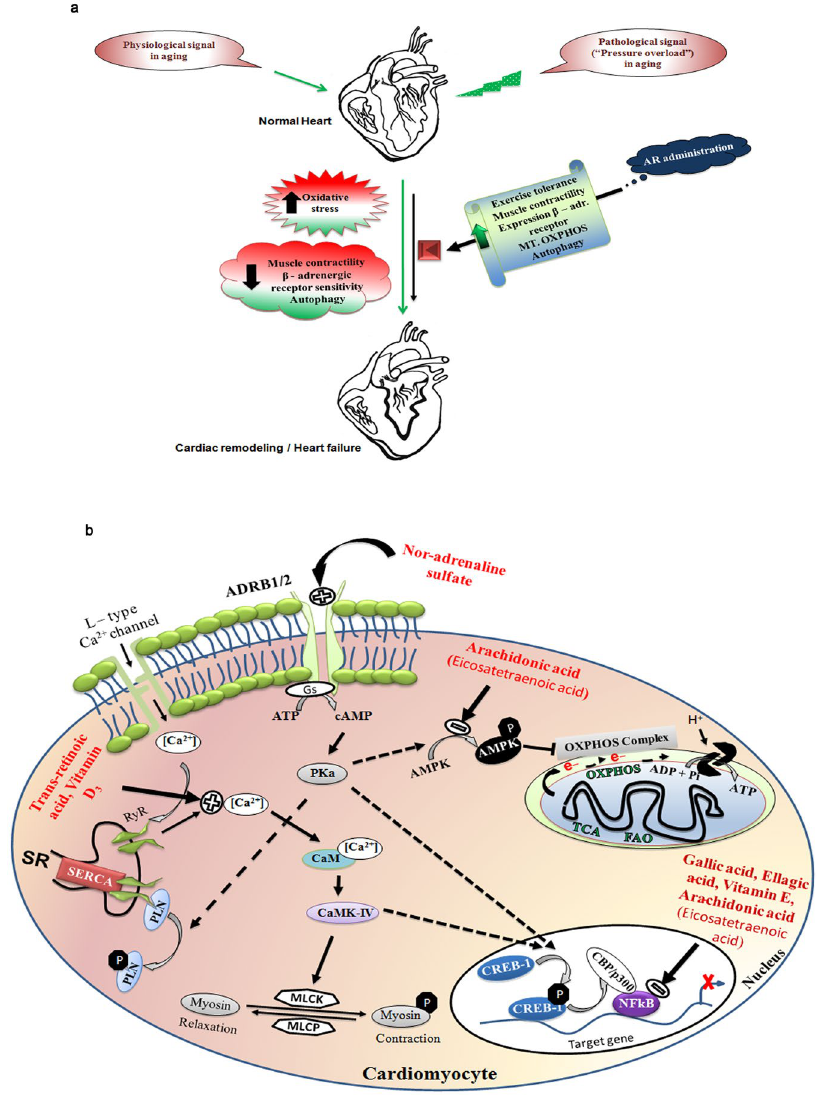
Figure 7. Possible molecular mechanisms of AR which improved the cardiac function in aged or aorta constricted group of rats. ( a ) AR administration attenuates the physiological and pathological signal (pressure overload hypertrophy) induced cardiac dysfunction in rats. ( b ) Nor-adrenaline sulfate activates the ADRB1/2 receptors which in turn activate CREB-1. Arachidonic acid, Gallic acid and Ellagic acid can inhibit pAMPK α or NFkB expression. Vitamin D 3 and trans-retinoic acid regulate [Ca 2 + ] in heart. pCREB-1, NFkB and pAMPK transcriptionally regulate muscle contraction, oxidative stress and mitochondrial bioenergetics function in heart